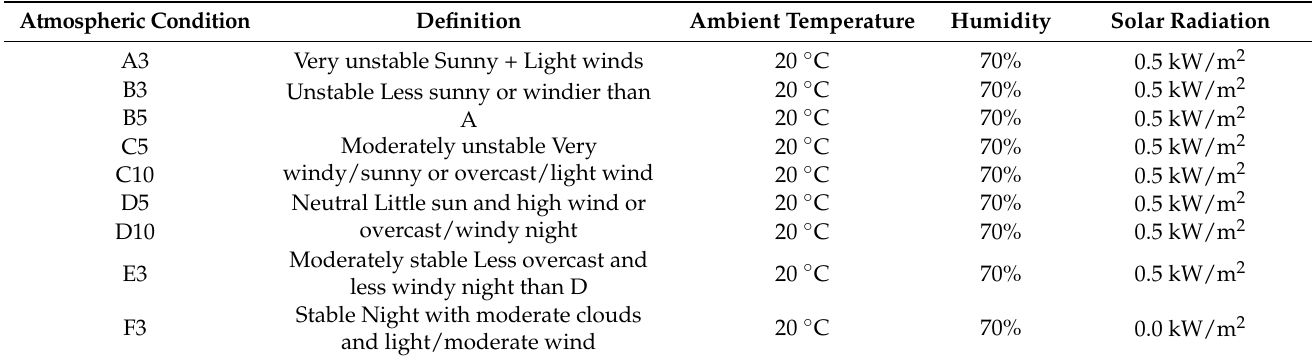
Table 6. Meteorological parameters of the Pasquill’s atmospheric